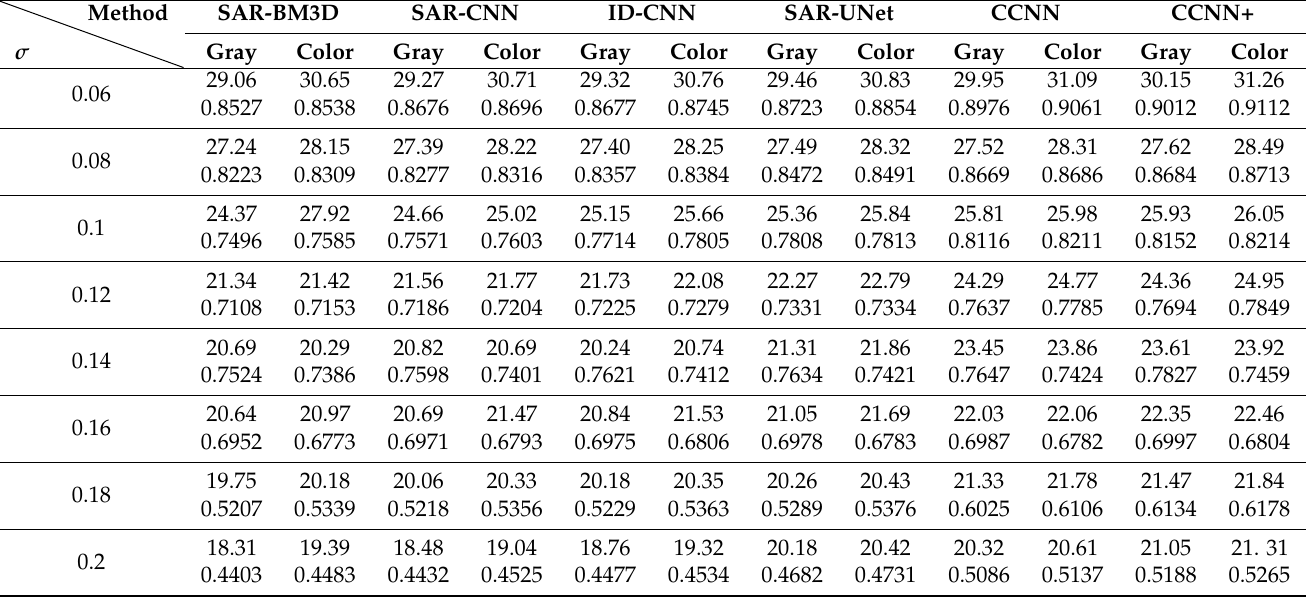
Table 2. Numerical comparison in terms of average PSNR (dB)/SSIM of different methods.